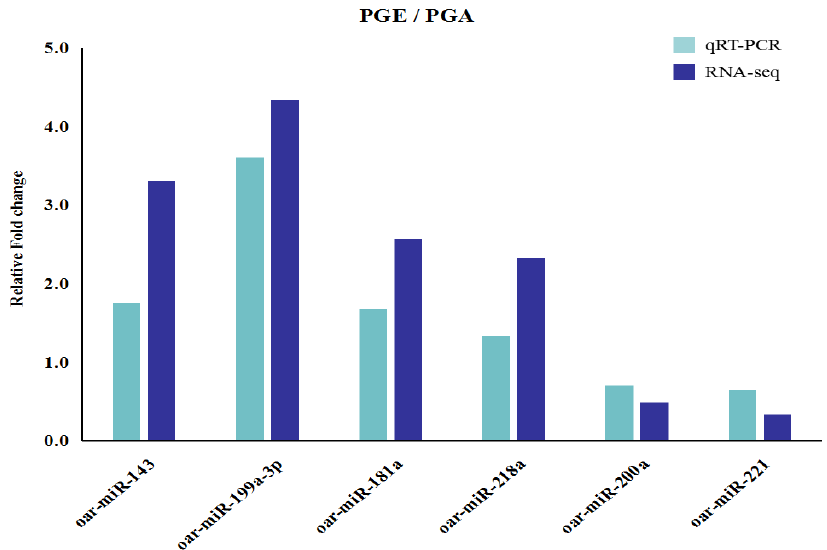
Figure 6. Validation of differentially expressed miRNAs by qRT-PCR. Six differentially expressed miRNAs expression levels as detected by qRT-PCR, and error bars indicate ± SD.